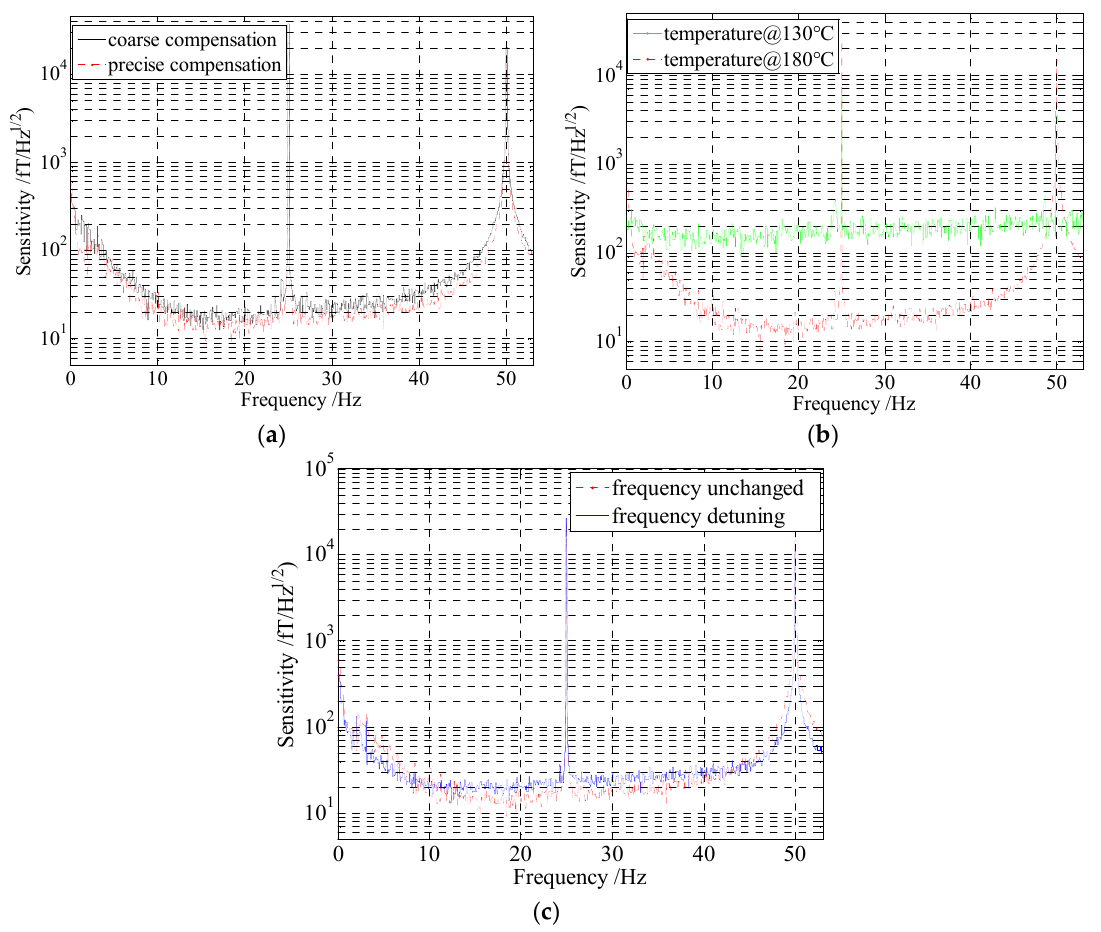
Figure 10. Experimental results of sensitivity comparison under the different situations. For each test, only one condition was changed. The dotted line acted as a comparison benchmark. ( a ) Optimization results of the residual magnetic field compensation in the magnetic shielding; ( b ) Optimization results of the temperature in cell; ( c ) Comparison results of the frequency detuning. On the basis of the un-optimized frequency, the frequency detuning was approximately 40